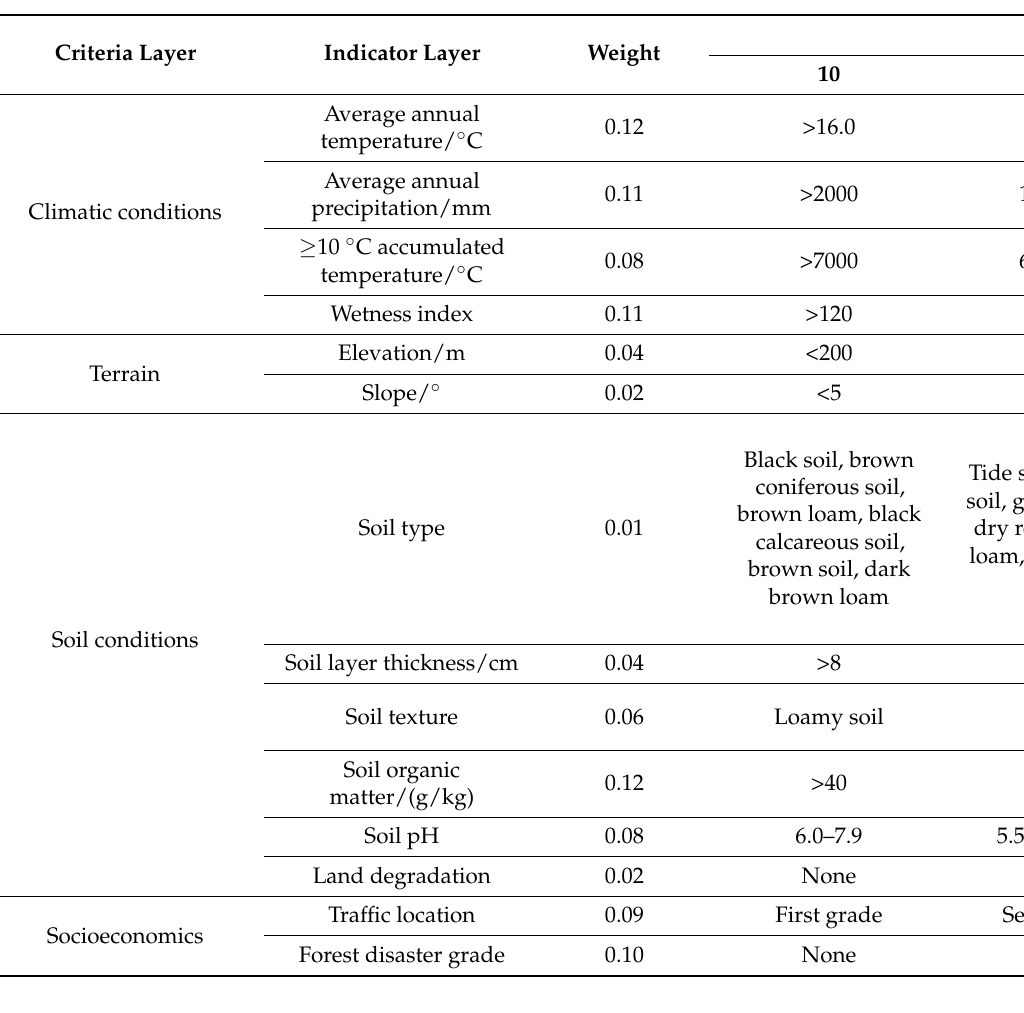
Table 1. Forest land quality evaluation indicator grading standards and their